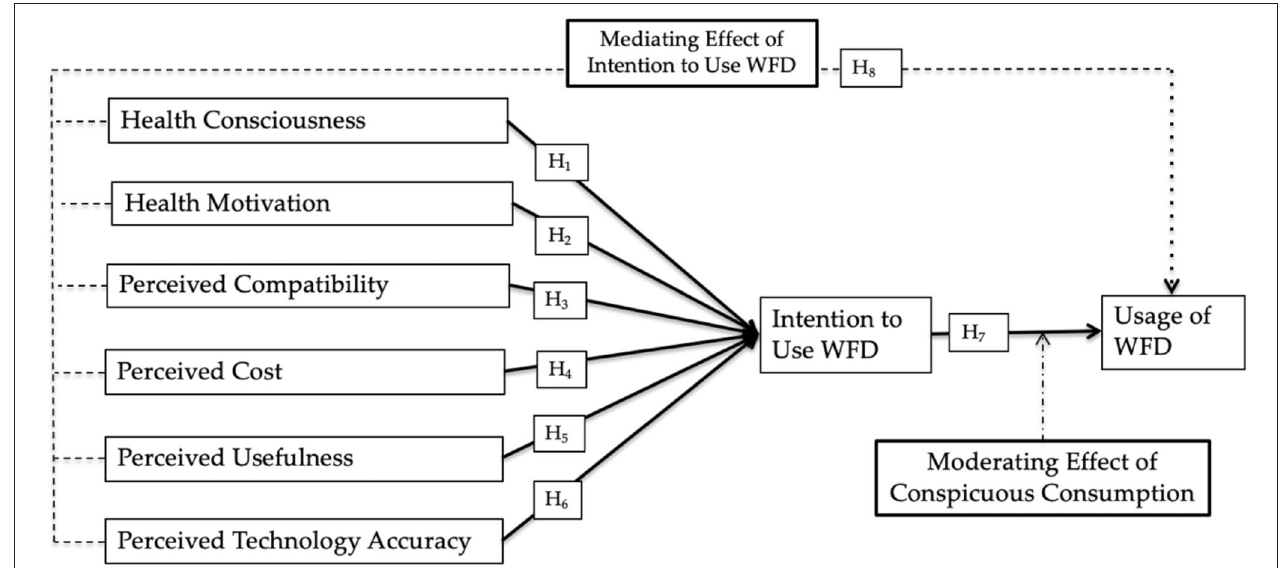
FIGURE 1 | Research